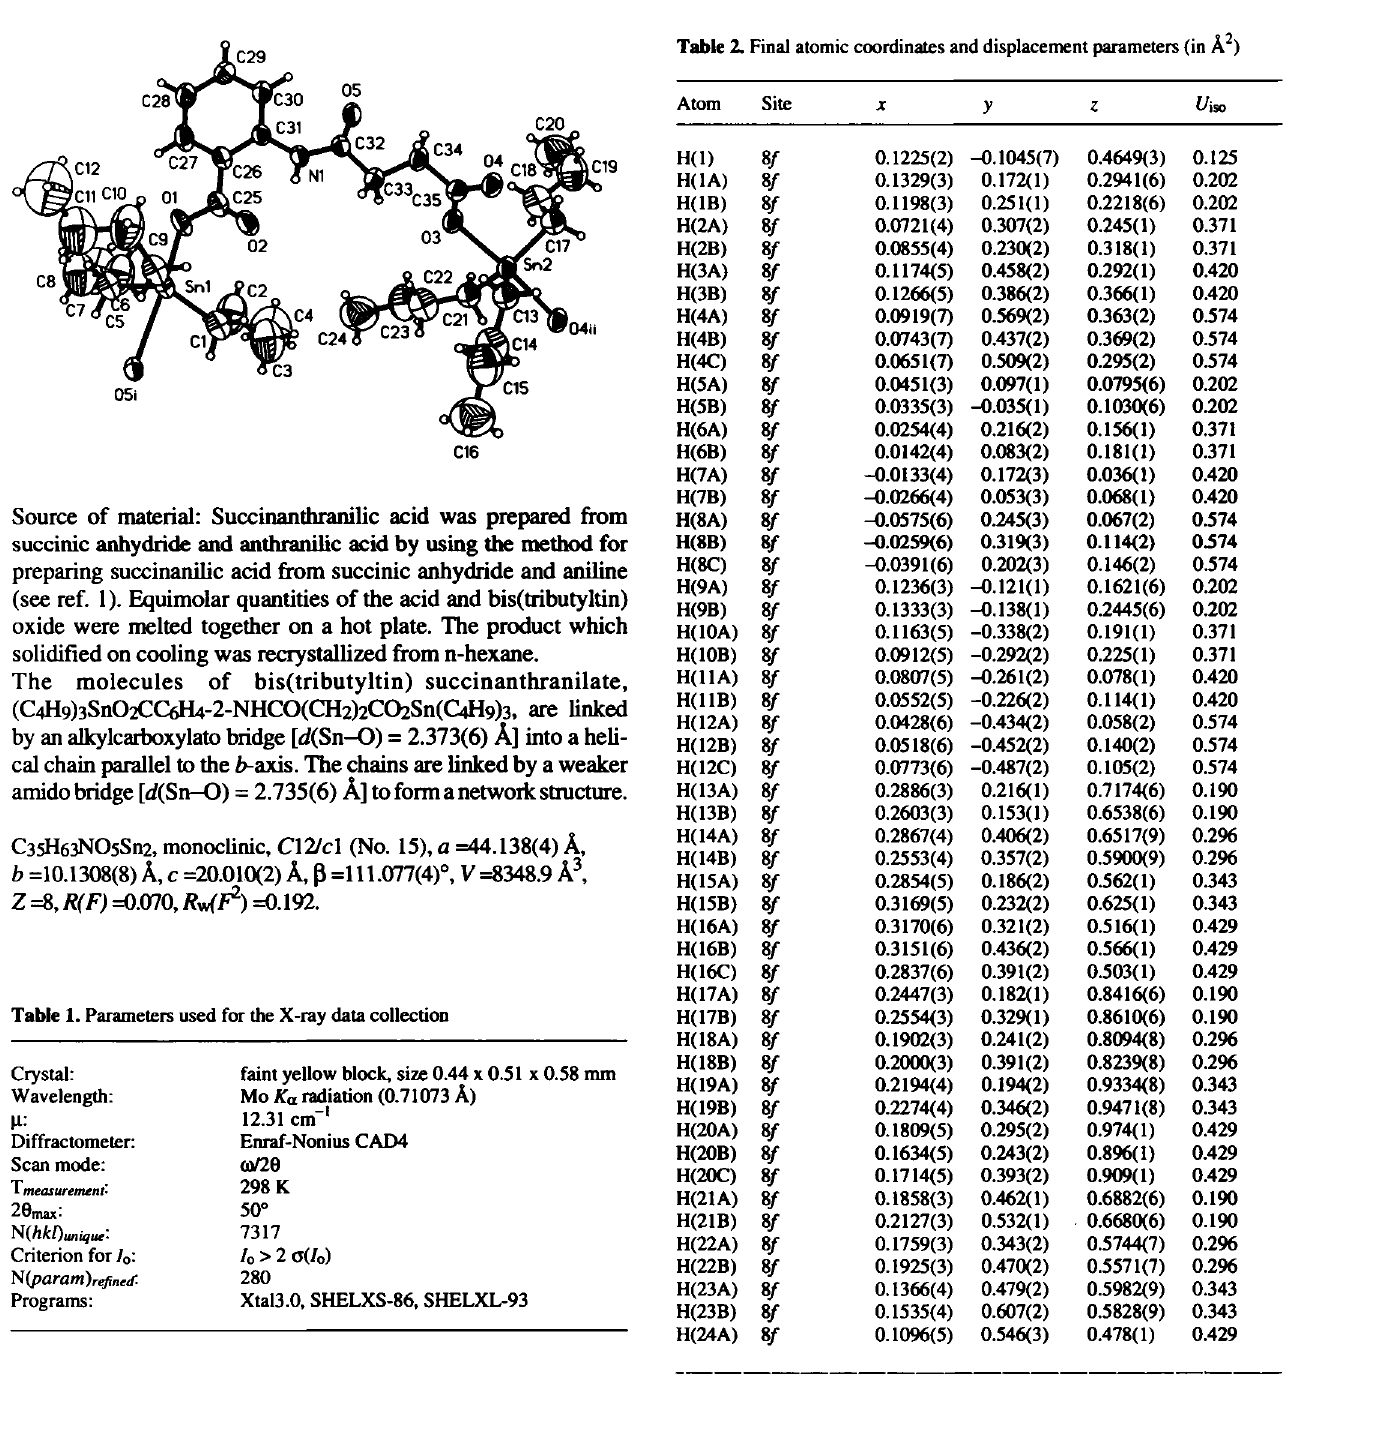
Table 2. Final atomic coordinates and displacement parameters (in A^)